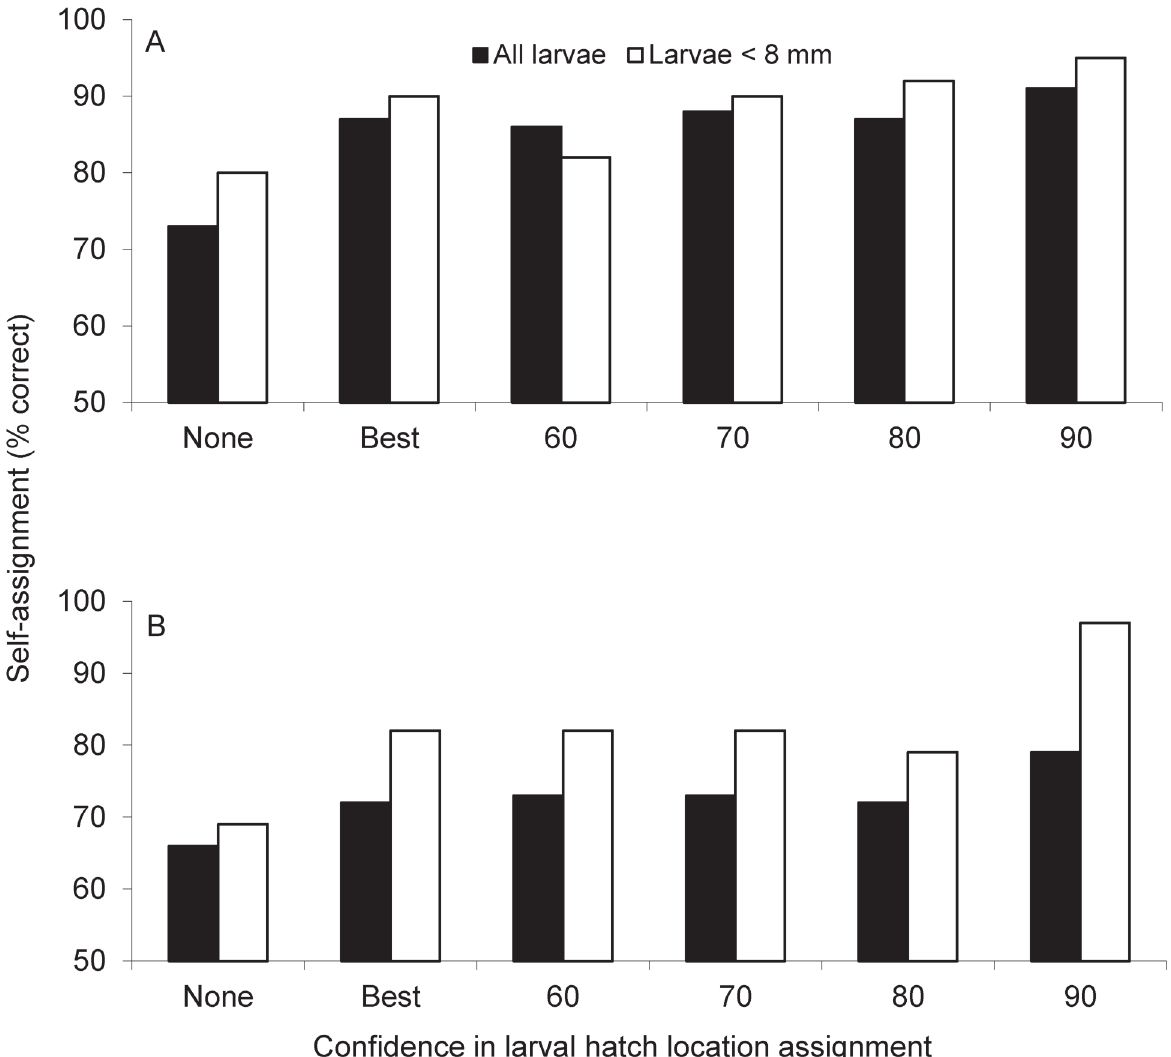
Fig 2. Self-assignment results based on microsatellite DNA data (seven loci) for larval yellow perch collected in Lake Erie ’ s western basin during a) 2006 and b) 2007. For sample sizes, see Table 2. Confidence in hatching locations is as follows: None = null assignments based on capture location (i.e., no backtracking used); Best = larvae assigned to single most likely hatching location (SS or NS) based on backtracking; and 60, 70, 80, 90 = larvae assigned to hatching location after backtracking revision with 60, 70, 80, 90% levels of certainty in hatching origin,